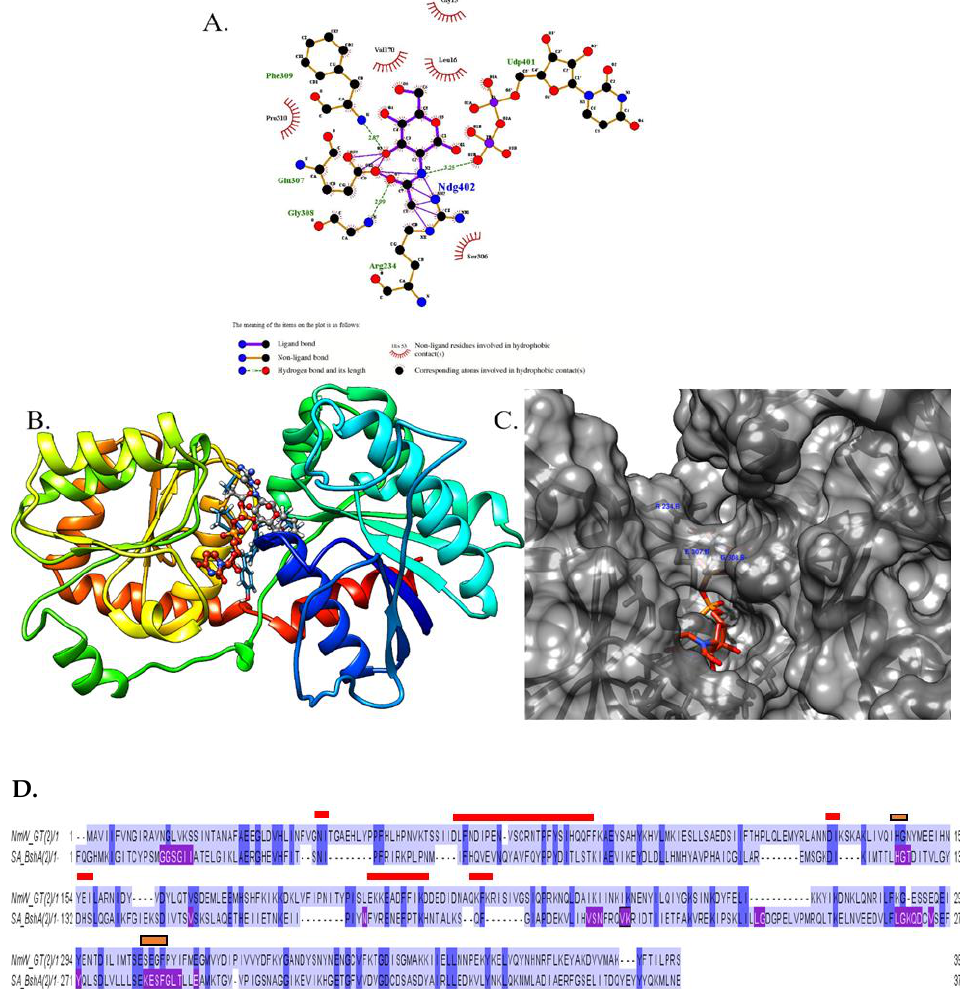
Figure 4. Model of the NmW-GT active site residues. ( A ) Proposed interactions of NmW-GT with UDP-N-acetylglucosamine. A 2D interaction map was generated with LigPlus and the legend is also shown. ( B , C ) Location of the active site identified through structural alignment. The NmW-GT model and BshA crystal structure were aligned with Matchmaker in UCSF-Chimera, and then BshA protein sequence was deleted. The UDP-GlcNAc ligand is colored using CPK scheme, and some amino acid side chains in the active site are shown as blue bonds on the ribbons. Residues potentially interacting with N-acetyl moiety and 4-OH groups are labeled in ( C ). ( D ) Pairwise sequence alignment of NmW-GT and BshA. Red indicates highly fluctuating regions in the molecular dynamics simulations (Supplementary Figure S3), purple indicates the residues in BshA that interact with the ligand, and gold represents residues that interact with the GlcNAc moiety in BshA and are conserved in NmW-GT. Secondly, docking was conducted with DOCK6, and the results are summarized in Supplementary Figure S2.